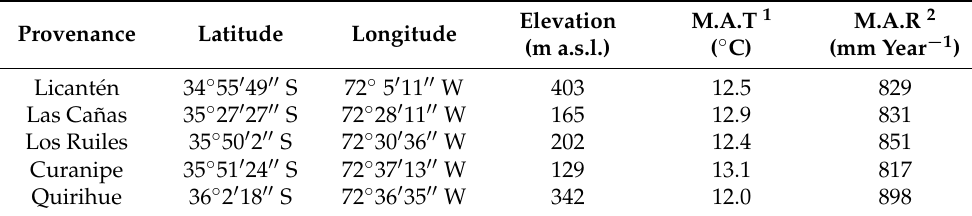
Table 2. Geographic and climatic data for provenances sampled. Provenance Latitude